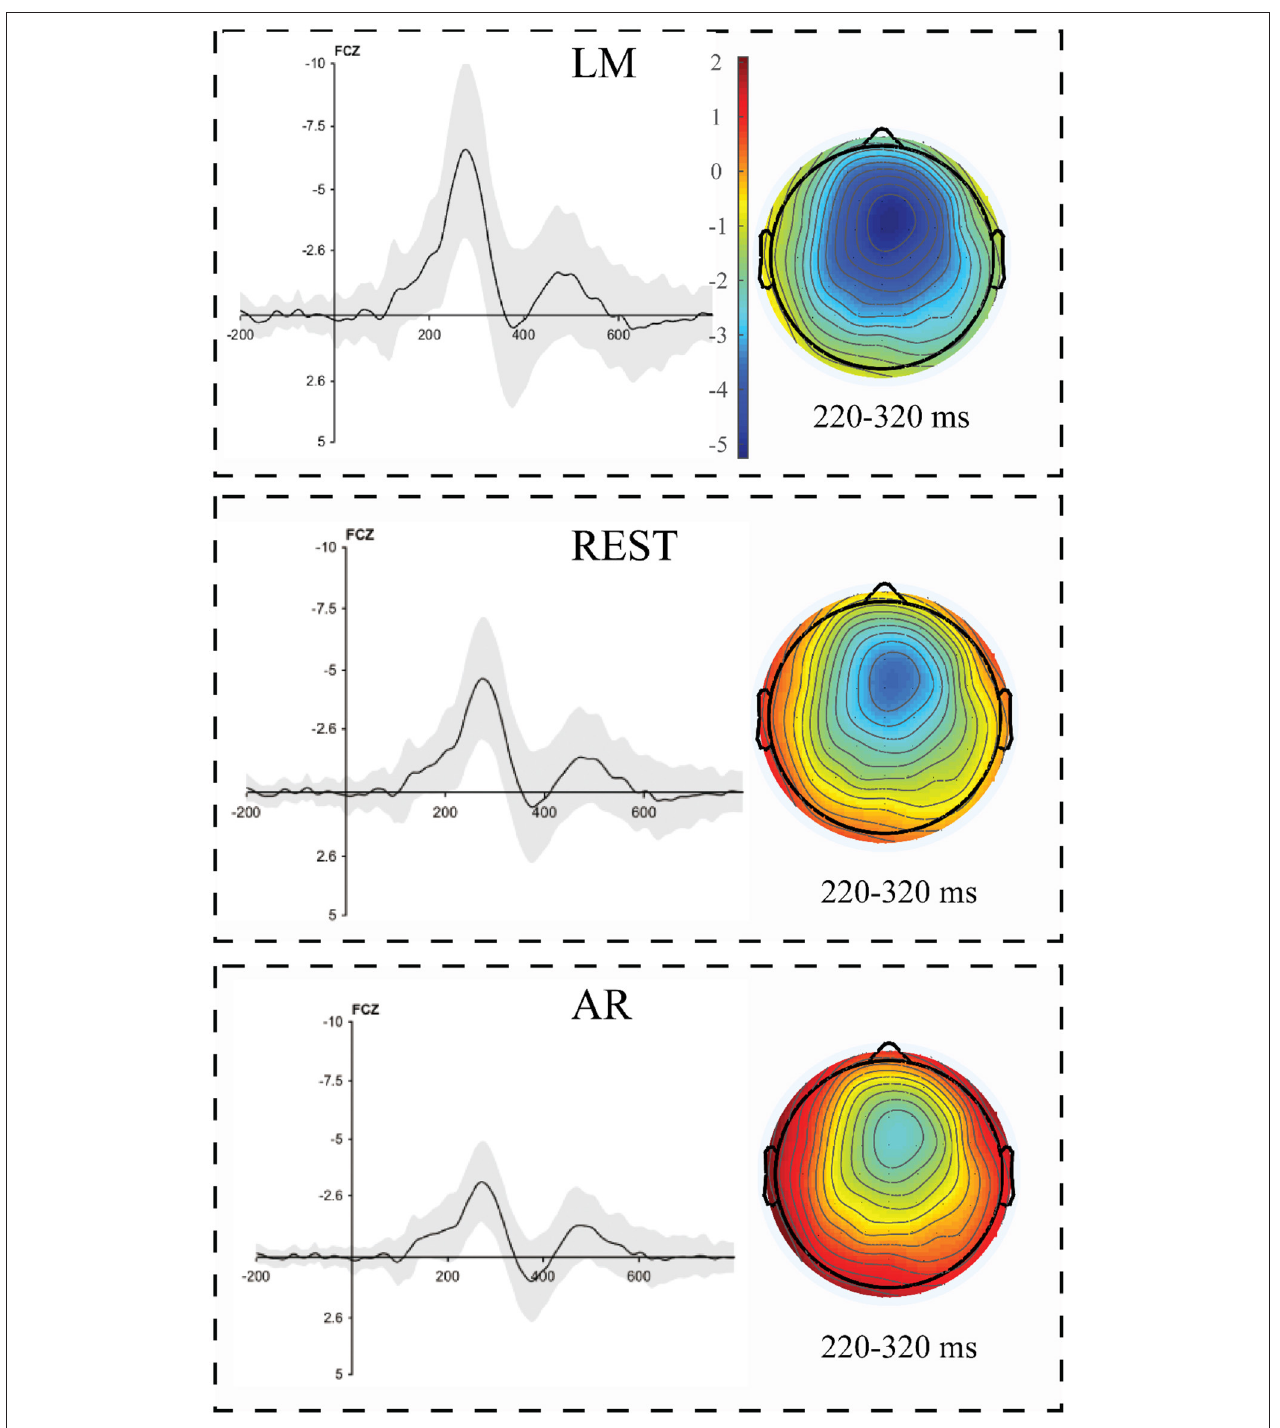
FIGURE 6 | The loss minus gain difference waveforms in a gambling task using three separate reference approaches. The corresponding topographical maps of the FRN effect (180–330ms) revealed a strong fronto-central distribution using all three reference approaches. The shading indicates the standard error across the